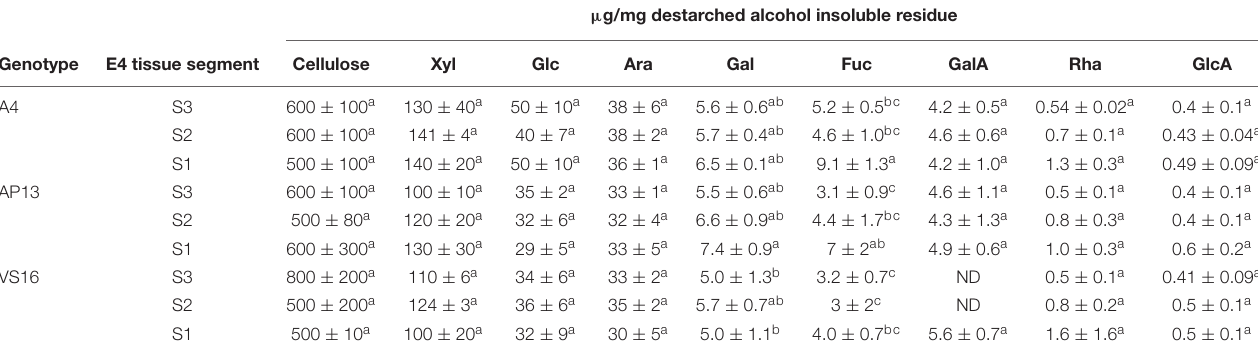
Data are mean ± standard deviation. n = 3. In each column, unshared letters indicate significant differences at P ≤ 0.05 as tested by Tukey’s range test. V3, vegetative stage 3; E4, elongation stage 4; R3, reproductive stage 3; Glc, non-crystalline cellulose glucose; Xyl, xylose; Ara, arabinose; Gal, galactose; Fuc, fucose; Rha, rhamnose; GalA, galacturonic acid; and GlcA, glucuronic acid; ND, not detected. TABLE 2 | Carbohydrate composition ( µ g/mg) of cell wall residue of elongation 4 (E4) tiller segments (S3–S1) from A4, AP13, and VS16 switchgrass. µ g/mg destarched alcohol insoluble residue